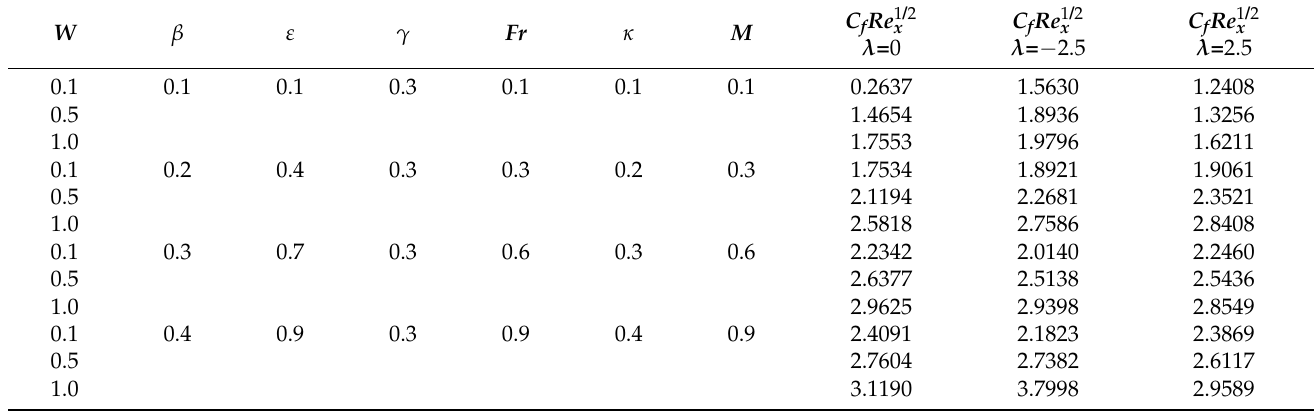
Table 2. Skin friction for various physical